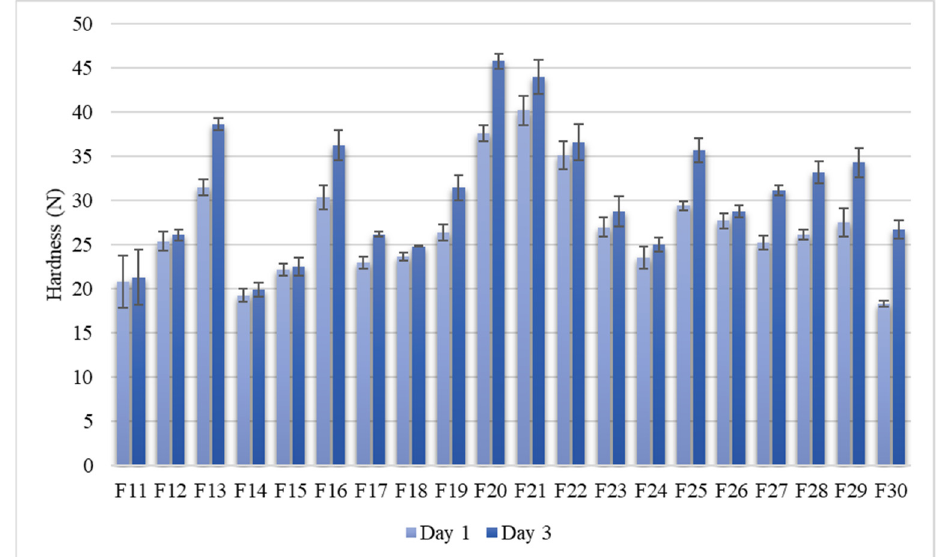
Figure 3. Bread crumb hardness (N) of the oat bread samples after 1 and 3 days of storage ( n = 3), measured with two-bite compression test of Texture Analyser (TPA, Texture Profile Analysis, Stable Micro Systems, UK). Error bars represent standard errors of the means (SEM).